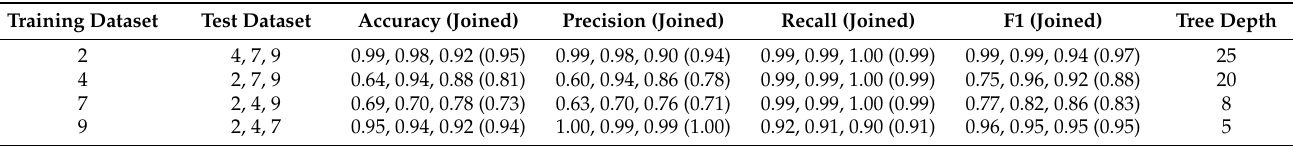
Table 5. Results using one dataset as training data.